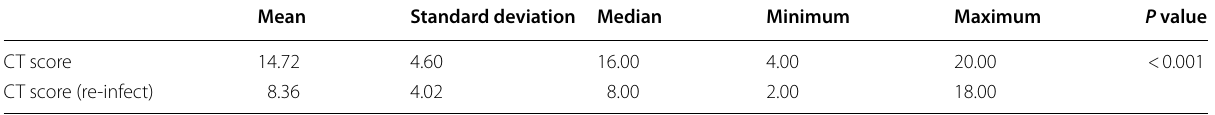
Table 6 Showed a significant decrease in the CT severity score of the re-infected COVID-19 patients (mean COVID-19 infection (mean 14.72), ( P < =